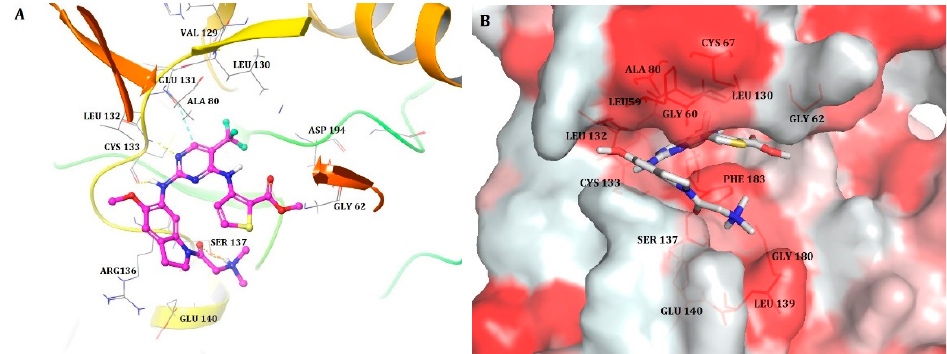
Figure 3. ( A ) Docked pose of the most active compound, 17 , within the active site of PLK1 (Hydrogen bonds are represented as yellow dotted lines, pi-pi interactions are represented as cyan dotted lines); ( B ) The most active compound 17 (shown in stick model) within the hydrophobic pocket of PLK1; the red colored region represents the most hydrophobic surface of the protein, and the white color represents the least hydrophobic surface. Hydrophobic residues are indicated with red lines.